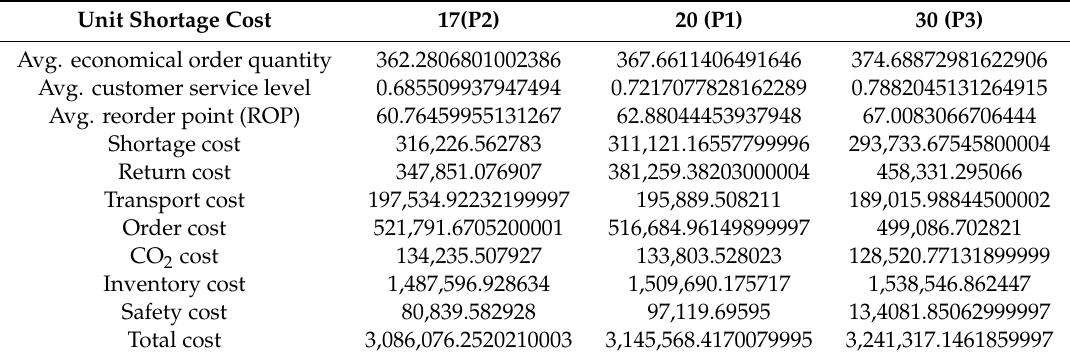
Table 14. The results of the sensitivity analysis for unit shortage cost regarding ROPIRPSDRCO 2 .